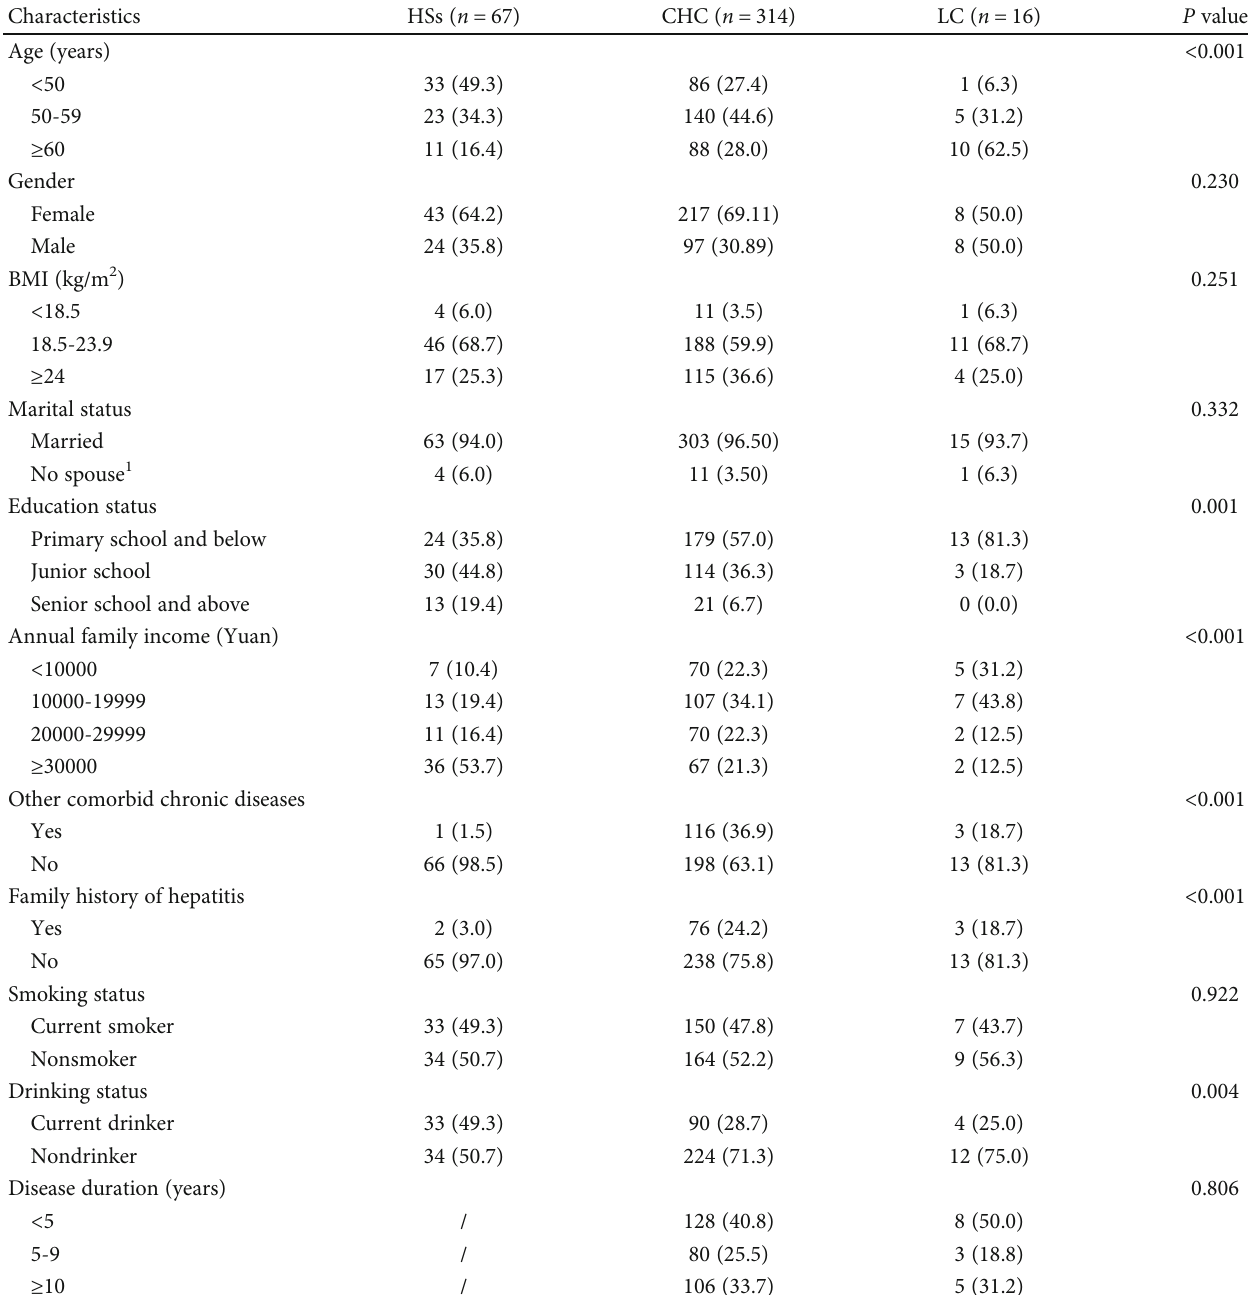
Table 1: Sociodemographic characteristics of all